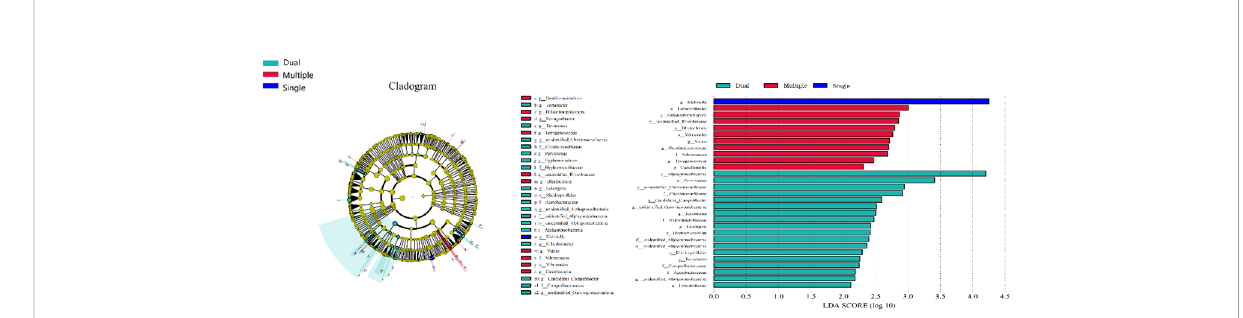
FIGURE 9 LEfSe analysis comparing microbial variations at the genus level in patients infected with one, two, or multiple HPV subtypes. LEfSe cladogram representing differentially abundant taxa ( p < 0.05). LDA scores as calculated by LEfSe of taxa are differentially abundant among groups. Only taxa with LDA scores of >2 were